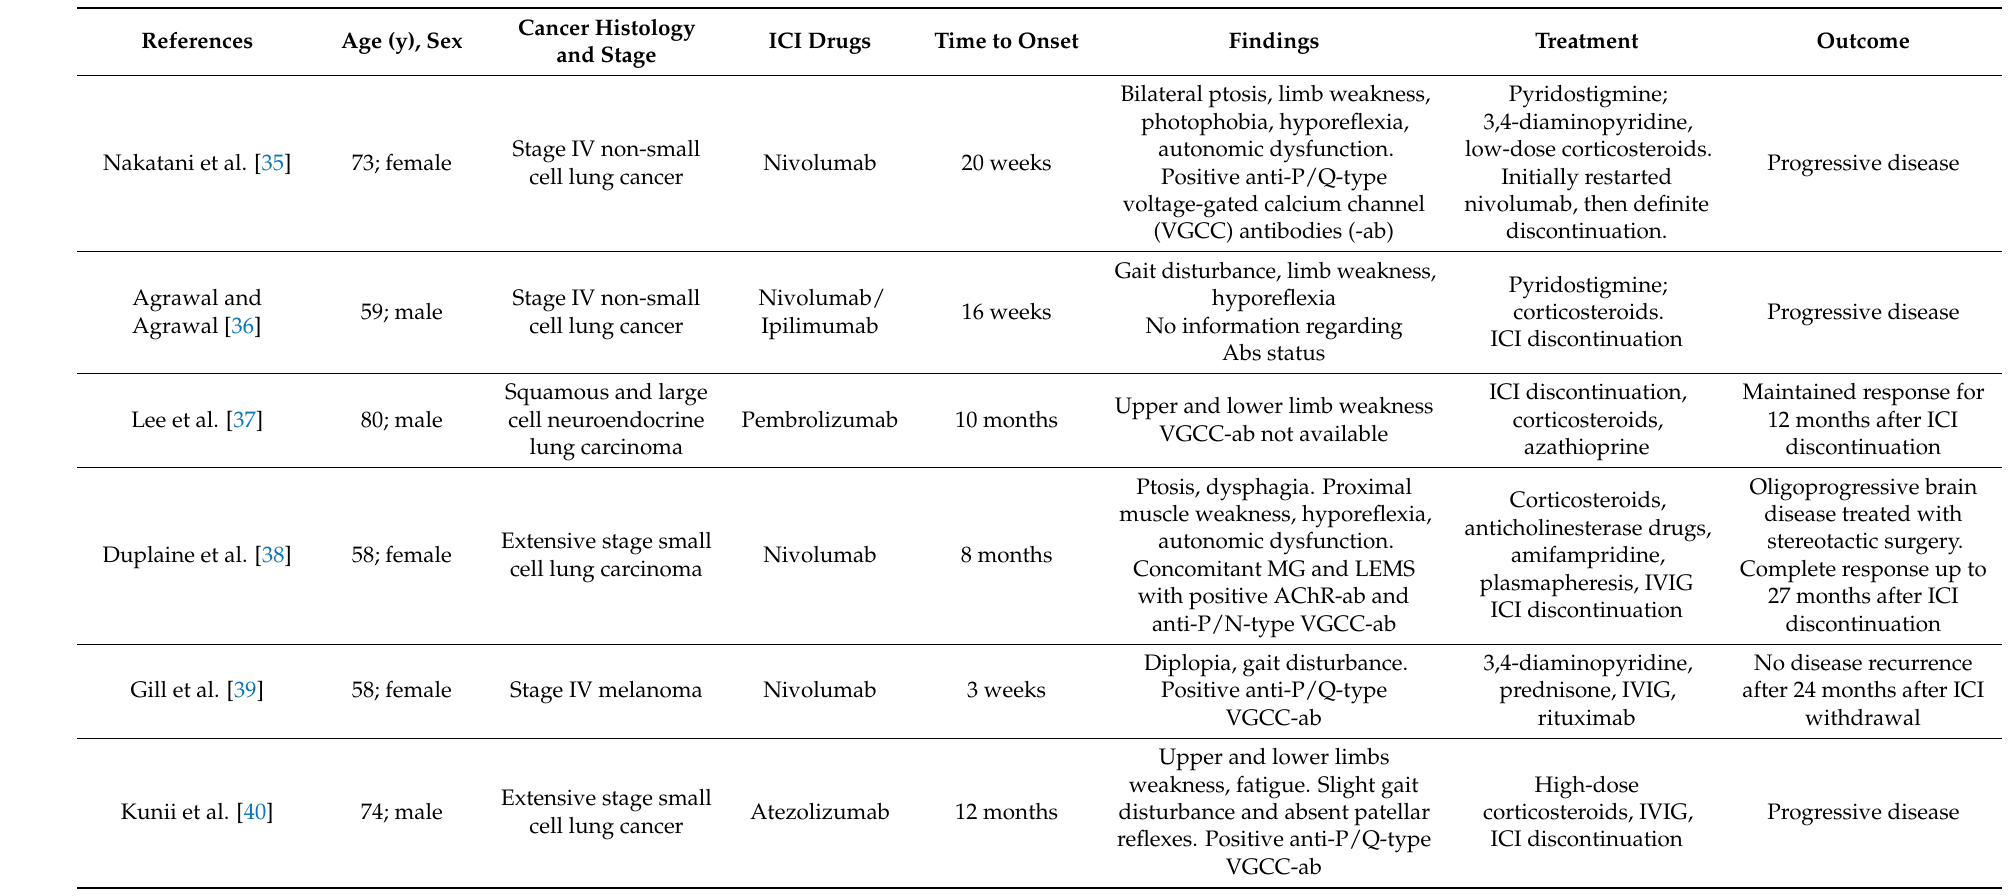
Table 1. Summary of reported cases of ICI-related